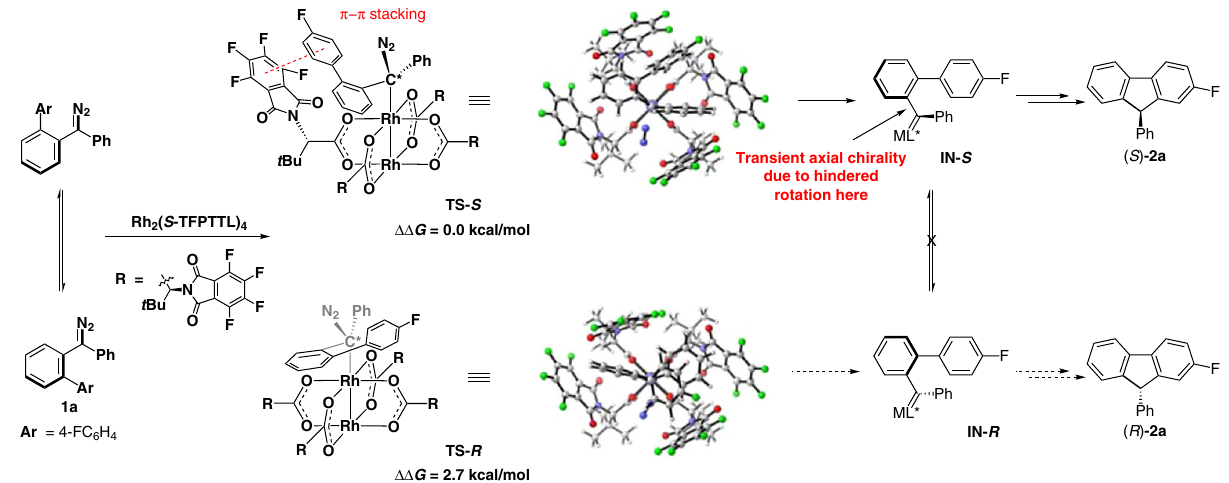
Fig. 2 Enantioselectivity transition states of reaction 1 with 1a to 2a as example. The forming of the S -con fi guration product 2a is the favored one ( TS- S is favored over TS- R by 2.7 kcal/mol. Calculations at SMD(toluene)-M06L-D3/Def2TZVP//PBE-D3/Def2SVP/W06 level).